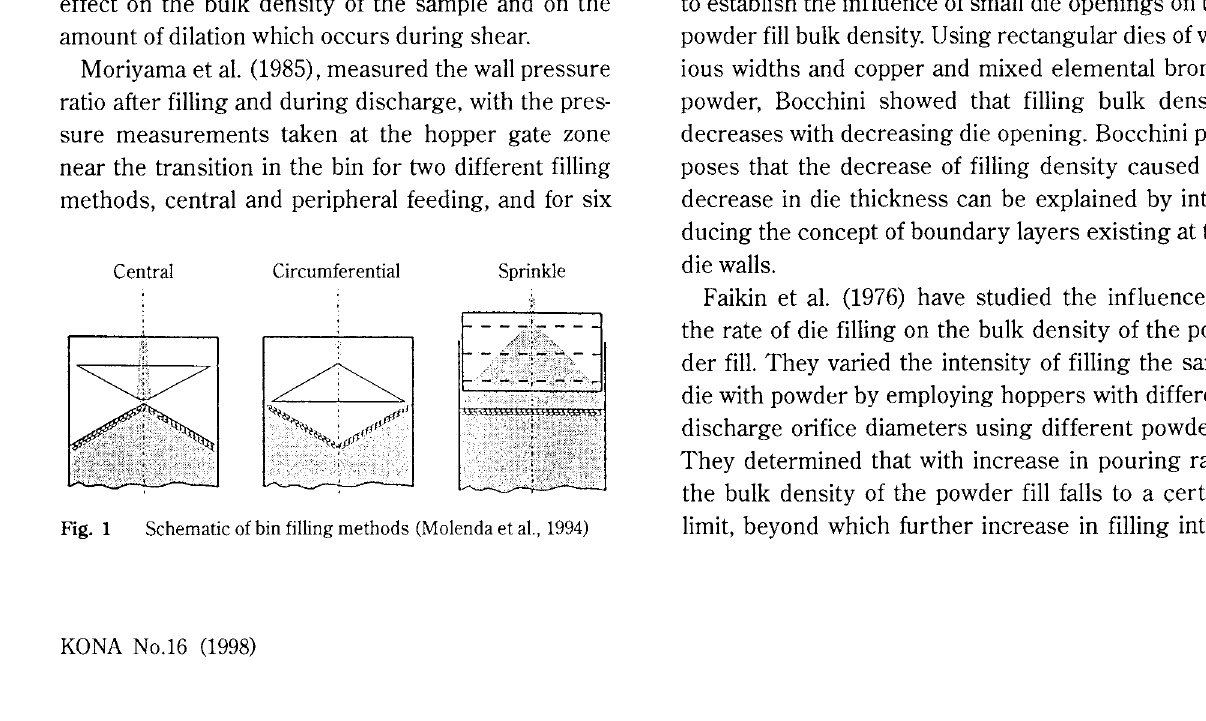
Schematic of bin filling methods (Molenda et al., 1994)